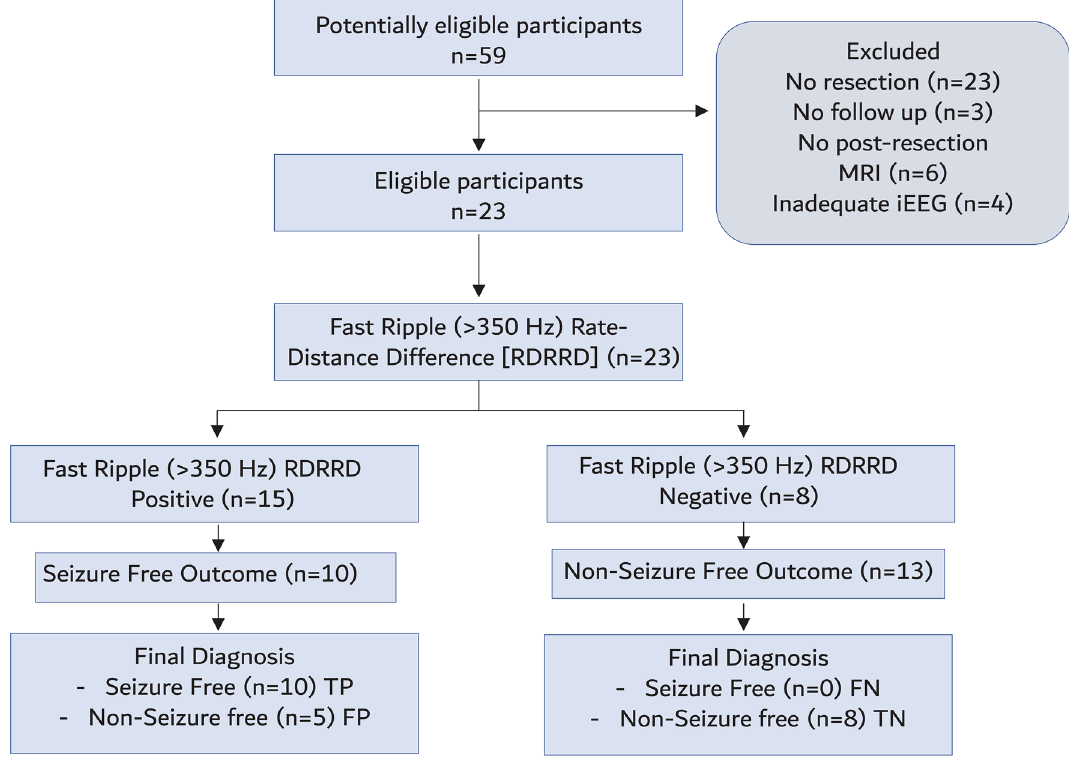
Figure 4. ( A ) STARD flow diagram of the diagnostic accuracy of the FR > 350 Hz rate-distance radius difference measure for predicting seizure freedom. The threshold was determined by the maximum of Youden’s J of the ROC curve ( B ) TP true positive, FP false positive, FN false negative, TN true